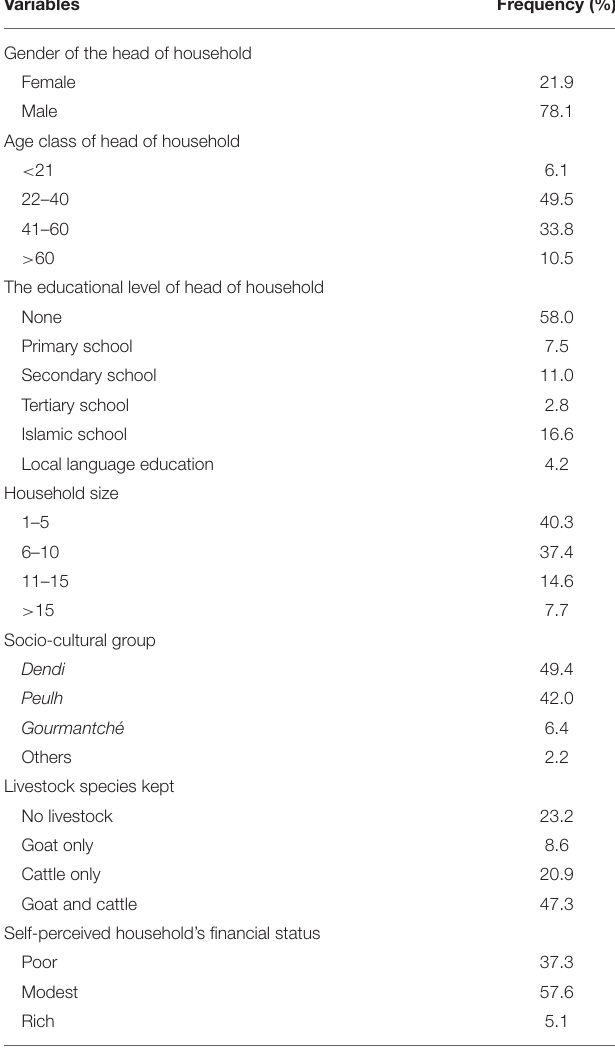
TABLE 1 | Socio-economic characteristics of households surveyed. Variables